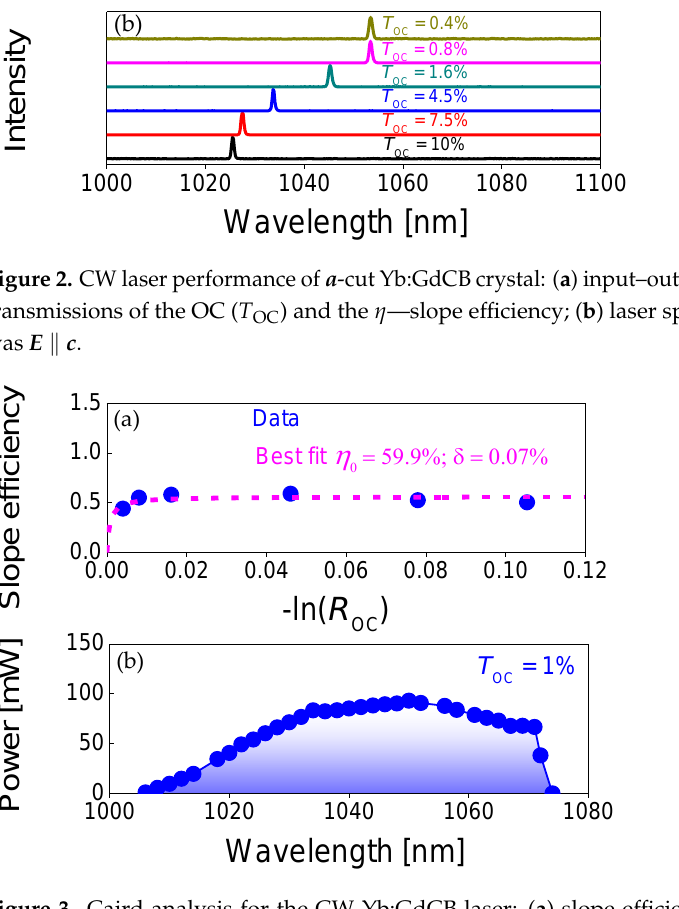
Figure 2. CW laser performance of a -cut Yb:GdCB crystal: ( a ) input – output dependences for dif- ferent transmissions of the OC ( T OC ) and the η — slope efficiency; ( b ) laser spectra. The laser polar- ization was E ‖ c .